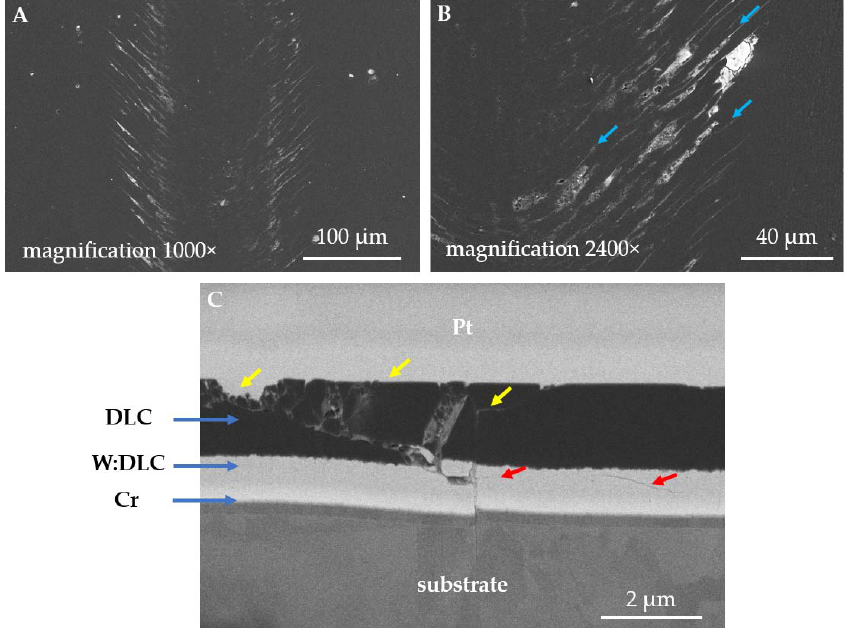
Figure 12. SEM micrographs of the wear tracks obtained for the DLC-coated 316L austenitic stainless steel (S3): ( A , B ) surface state of the wear track, ( C ) FIB-SEM cross-section of a wear track.